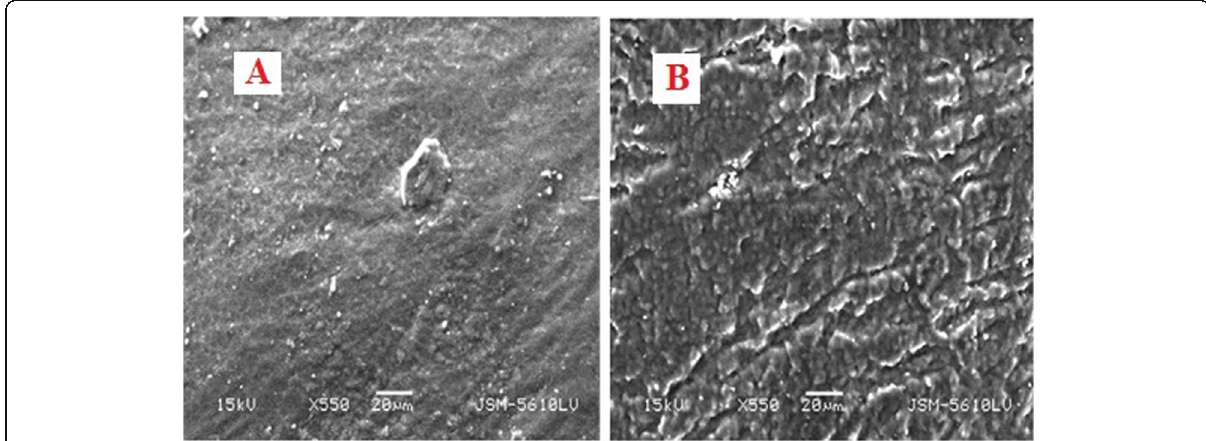
Fig. 8 SEM micrographs: hydrogel containing 10% w/w PVA, 5% w/w PEG 400, and 0.2% w/w embelin. a Before and b after